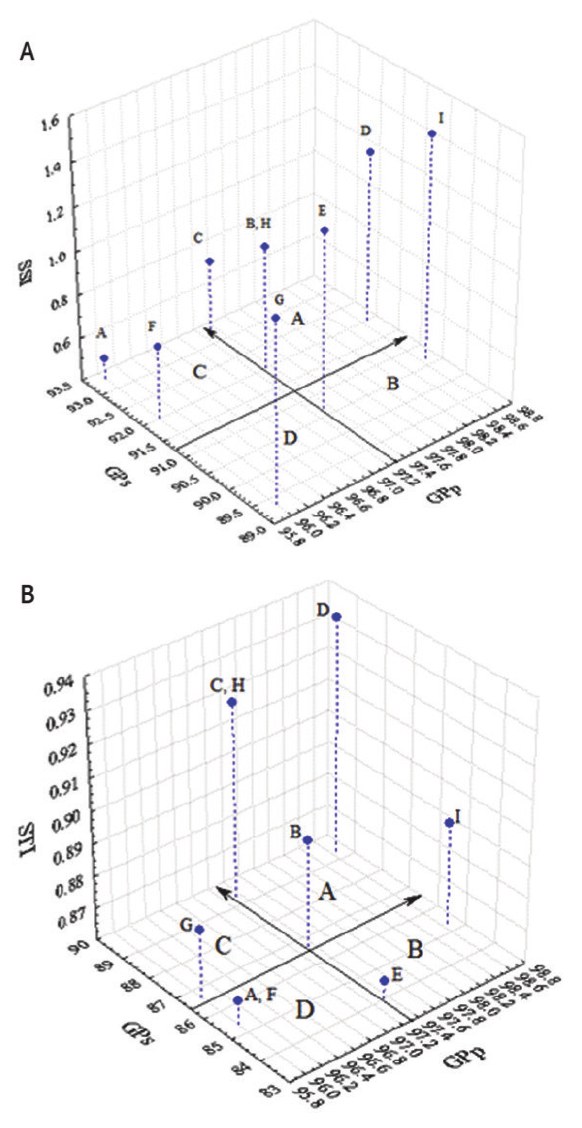
Figure 1 : Dispersion between GPp, Gps and tolerance indices, A: S1 (4.5 ds/m) vs. S3 (10.5 ds/m), B: S1(4.5 ds/m) vs. S5(16.5